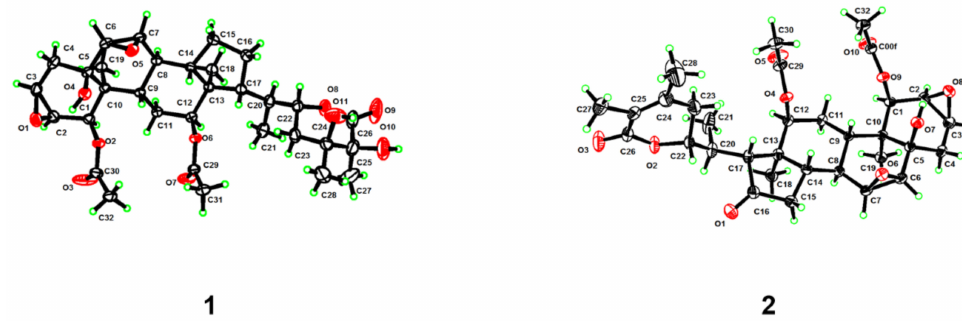
Figure 2. Perspective ORTEP drawings for compounds 1 and 2 .